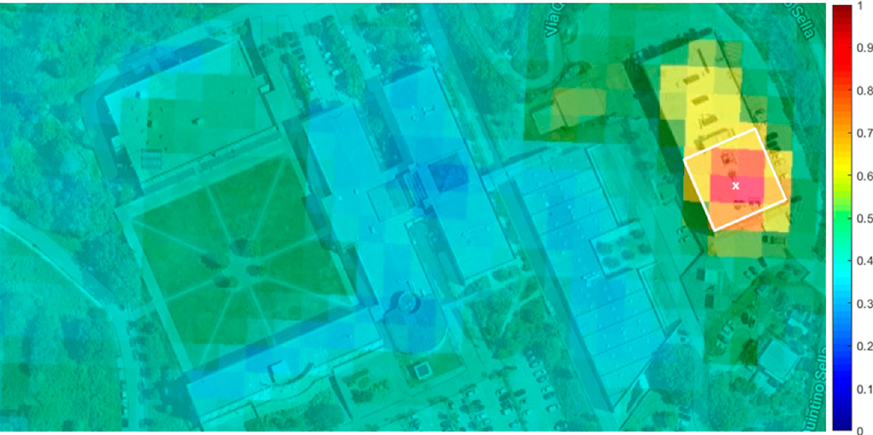
Figure 5. Albedo map of the SUT from Sentinel-2 satellite—19 July 2022. The albedo value from Sentinel-2 in the unit area where the albedometer is located is equal to 0.837. At the same time of the satellite passage, the albedo ground measurement is 0.846. Figure 6 shows the ground albedo measurement (blue line) and calibrated albedo (red line).